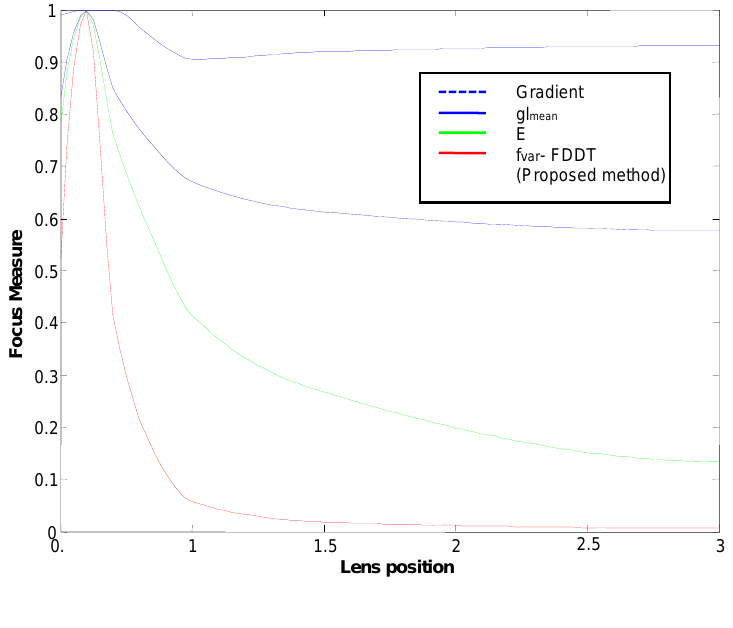
Figure 8. Focus measure for different images and lens position.